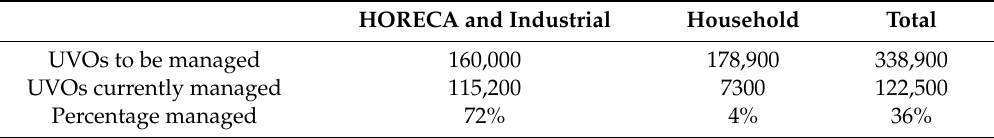
Table 1. Current data on used vegetable oils’ (UVOs) collections in Spain and future outlooks